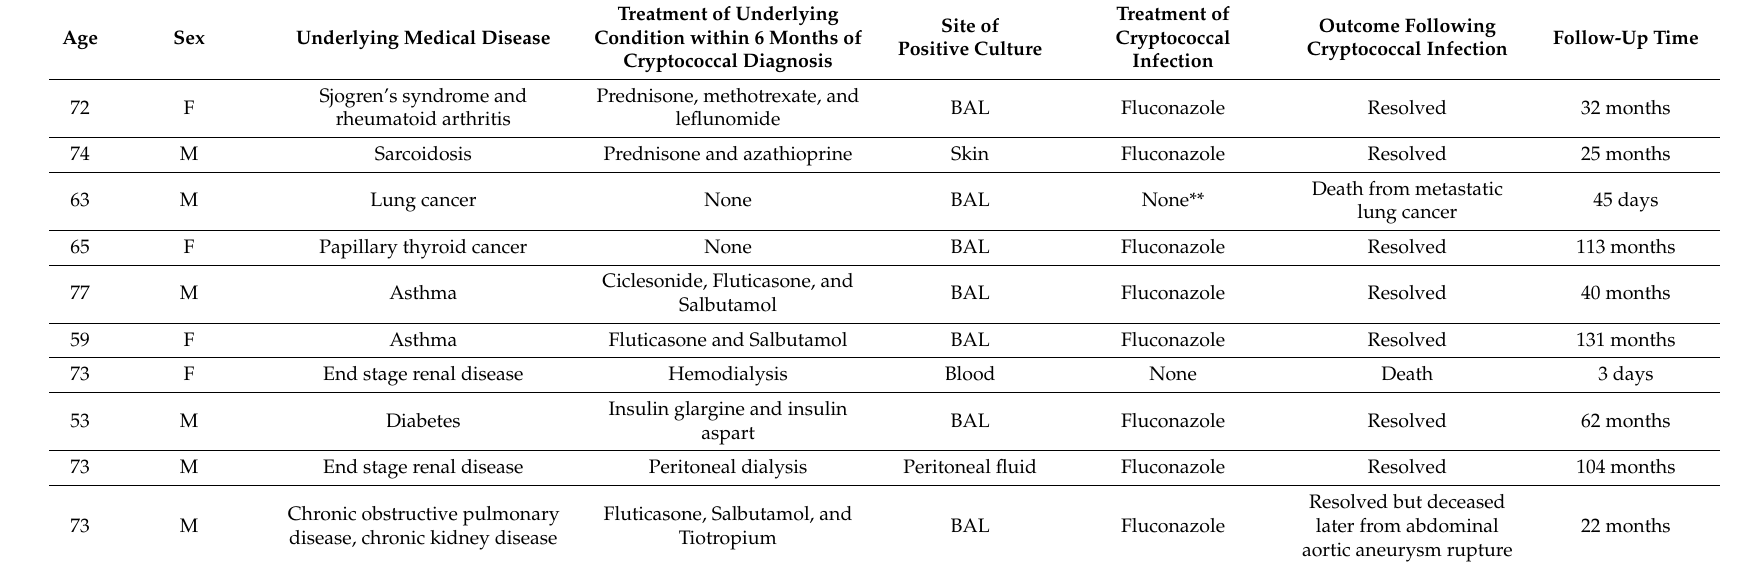
Table 1. Patient characteristics and